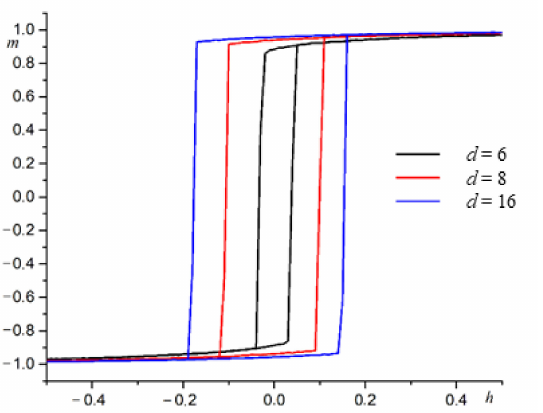
Figure 6. An example of hysteresis loops for a = 4 and different antidote lattice period d : d = 6 (black line), d = 8 (red line), d = 16 (blue line).